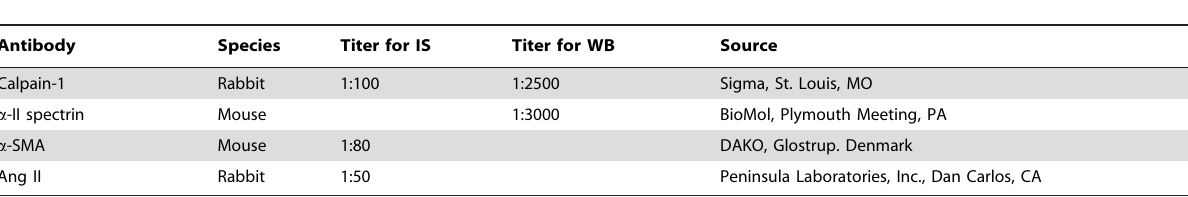
Table 2. Primary antibodies used for immunostaining (IS) and Western blotting (WB)